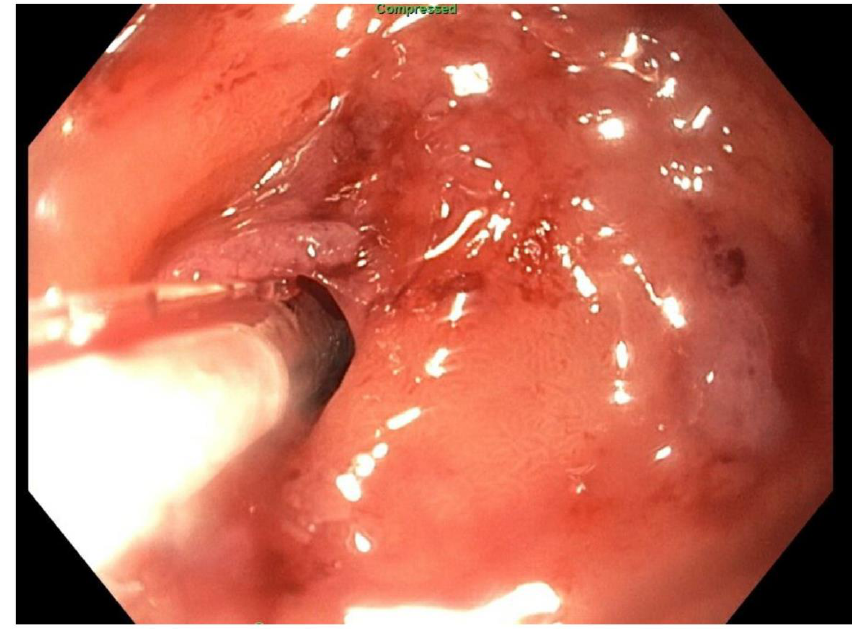
Figure 13. Balloon dilation across the divide.